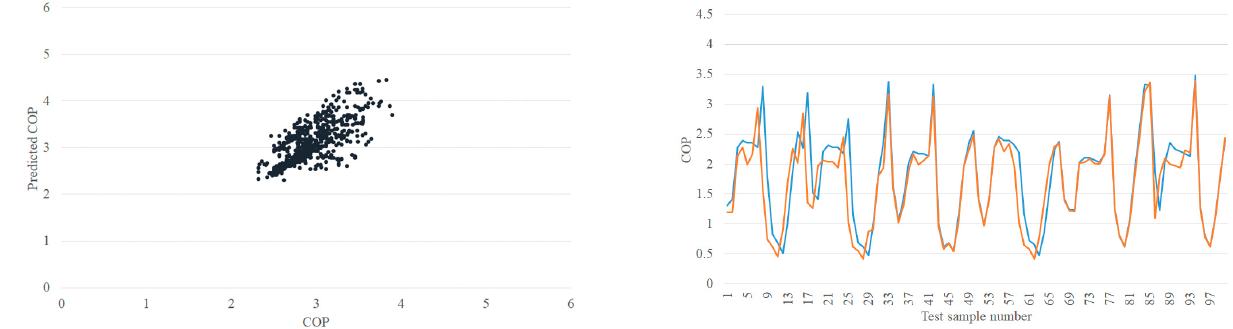
Figure 7. Comparison of predicted and measured performance using RF model.